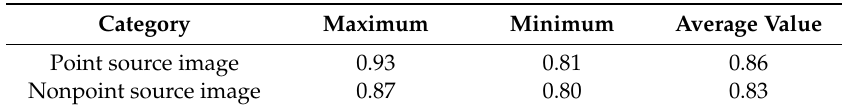
Table 1. Maximum, minimum, and average values of point source image and degree of similarity for nonpoint source image.